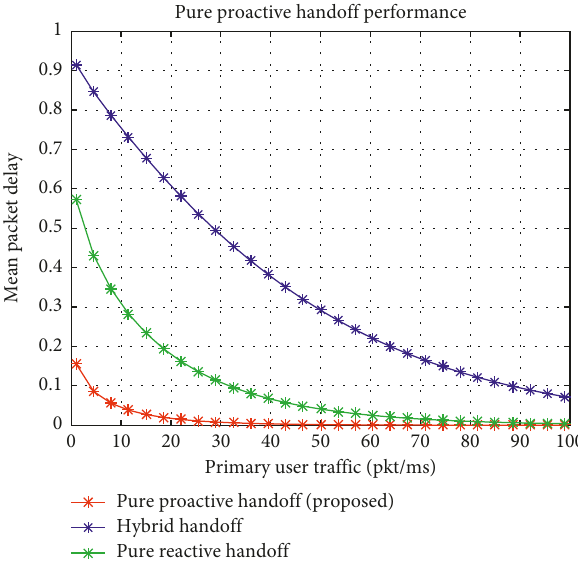
Figure 7: Performance of different spectrum handoff techniques regarding the potential collision